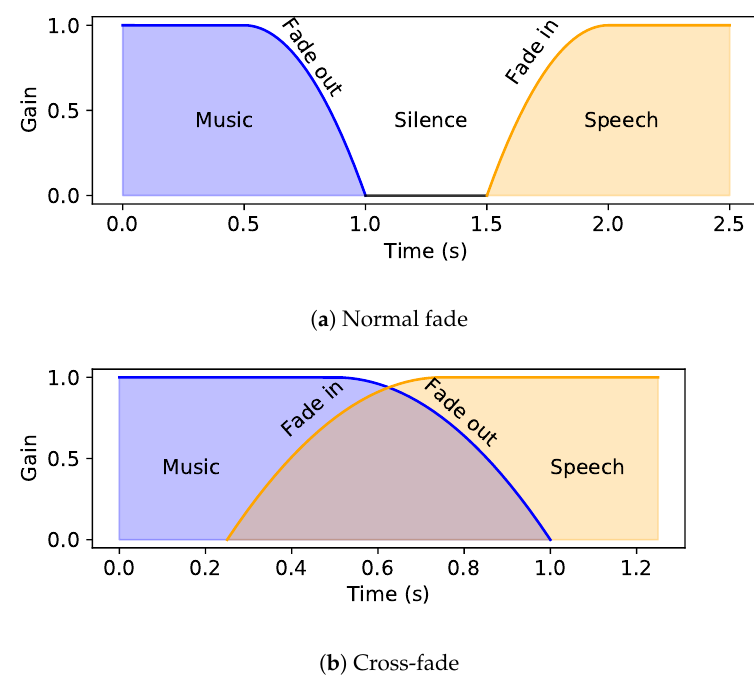
Figure 1. Two types of audio transitions in multi-class